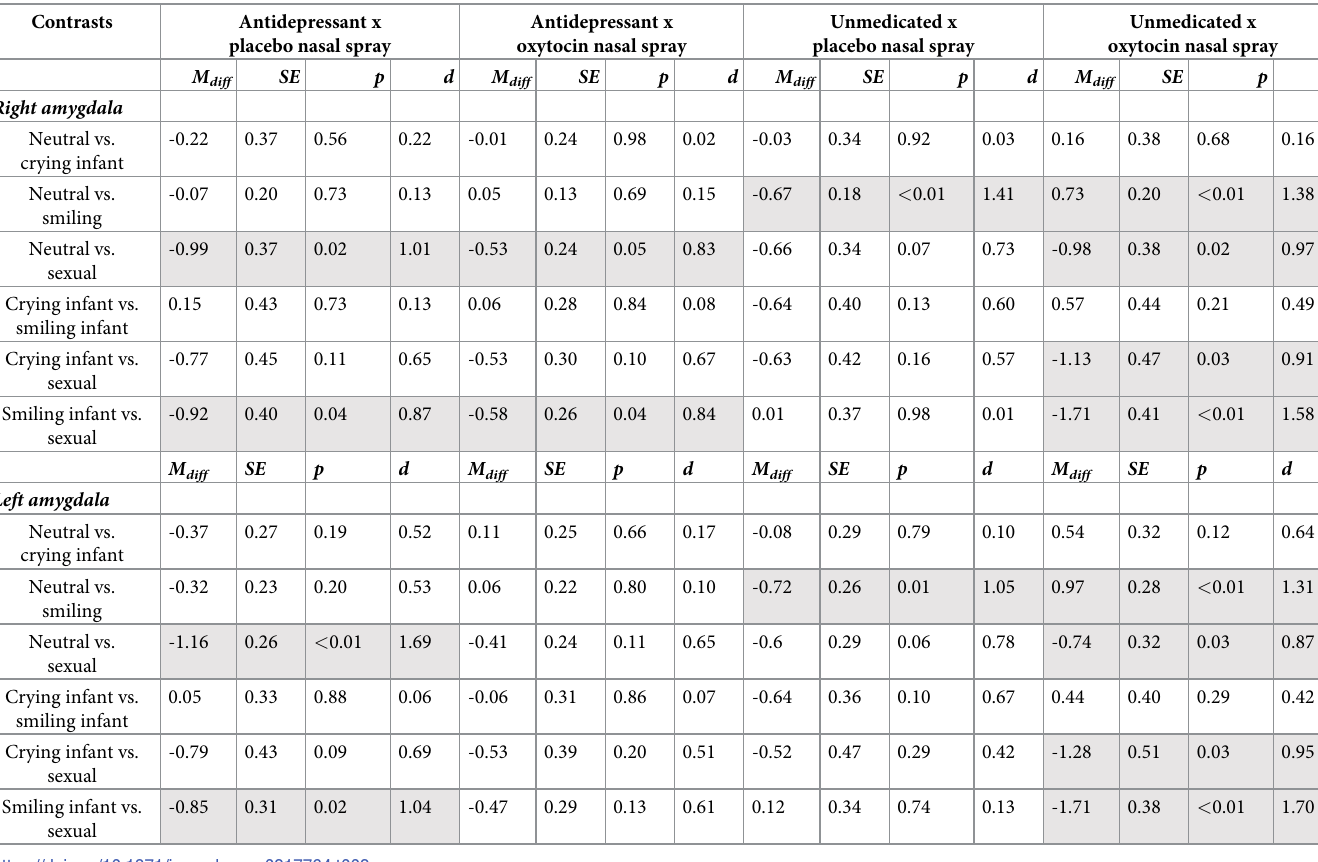
Unmedicated x placebo nasal spray